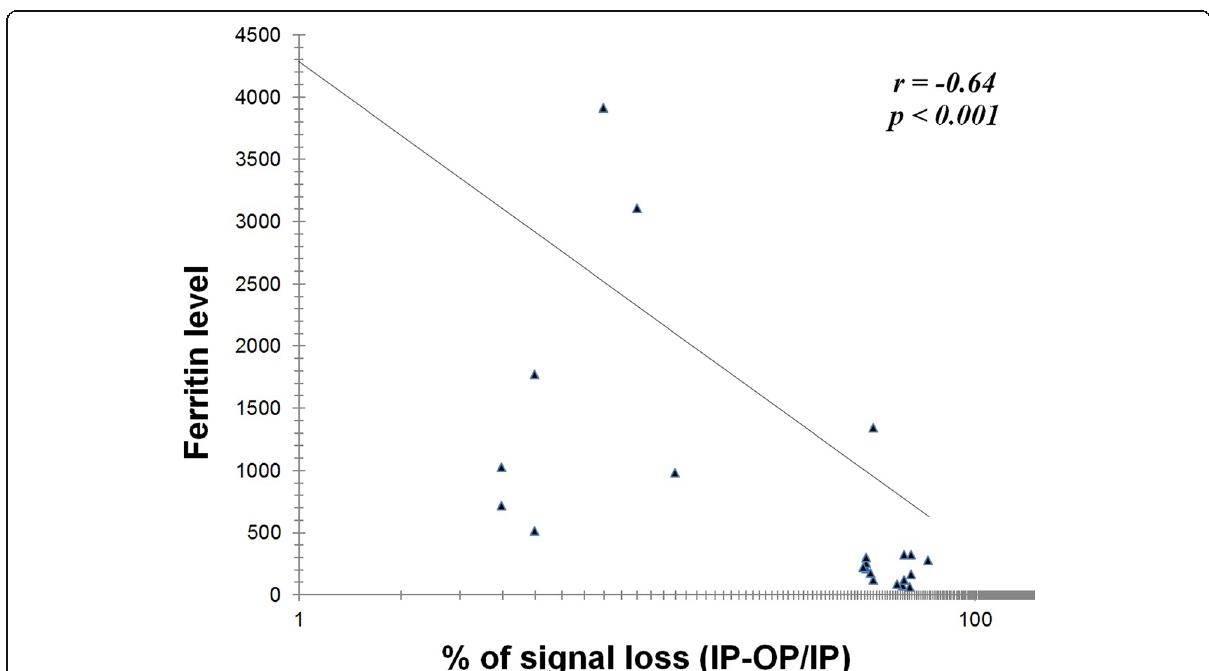
Fig. 2 Correlation scatterplot, expressed in a logarithmic scale, demonstrates significant high negative correlation between the serum ferritin level and the percentage of signal loss on CSI